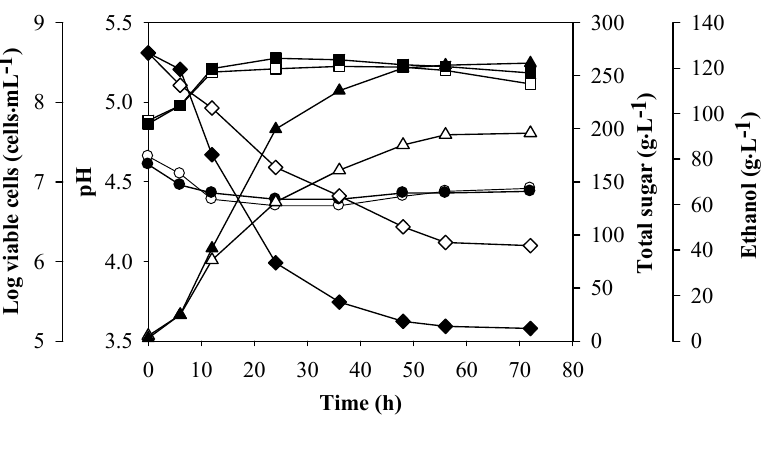
Figure 4. Batch ethanol fermentation in 2-L fermenter from sweet sorghum juice containing 280 g·L − 1 of total sugar and nutrient supplements at the optimum concentrations (closed symbols) and without nutrient supplement (open symbols): pH ( ●○ ), log viable cells ( ■□ ), total sugar ( ■□ ) and ethanol ( ▲ (cid:4574)